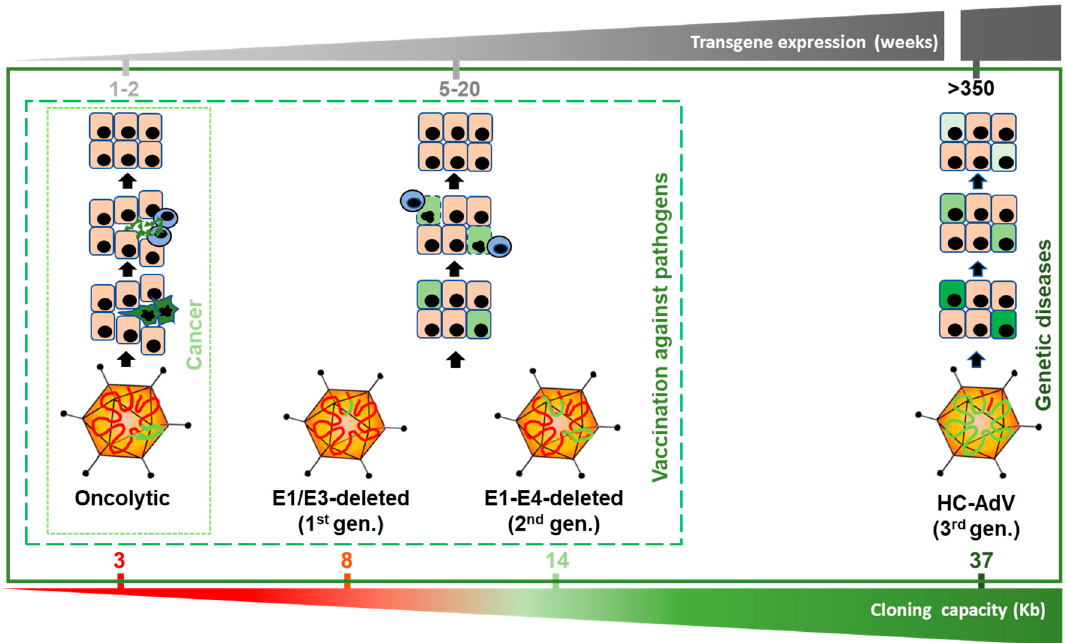
Figure 1. Versions of adenoviral vectors and potential therapeutic applications. The size range allowed for genome packaging is between 28 and 38 Kb. Oncolytic adenoviruses retain most of the viral genome, including the E1 region, which is required for replication. They can accommodate up to 3 Kb of exogenous DNA if the E3 region is partially deleted. Since they replicate their genomes and cause the lysis of infected cells, transgene expression is very intense but transient. Among replication-deficient vectors, E1 / E3-deleted (1st generation) versions can harbor up to 8 Kb. This capacity can be extended up to 14 Kb if the E2 and E4 regions are also deleted (second generation). Although these vectors do not cause direct destruction of infected cells, cytotoxic immune responses against them limit the stability of transgene expression. Apart from vaccination strategies, E1 / E3-deleted vectors are still a widely used research tool for in vitro and in vivo gene transfer. High-capacity adenoviral vectors (HC-AdVs) (third generation) only retain short non-coding regions from the AdV genome (ITRs and ψ signal), which leaves a cloning capacity of 37 Kb. The lack of viral gene expression in transduced cells reduces cellular immune responses and allows long-term transgene expression, which decreases slowly as the cells are renewed. HC-AdVs are suitable for all in vivo applications, including gene supplementation and gene correction for monogenic diseases. The indicated duration of transgene expression is based on liver-directed transduction in NHP, but it can be different in other hosts and tissues. In vector genomes, viral DNA is represented in red and exogenous DNA in green (including expression cassettes and/or DNA templates, and stuffer DNA).